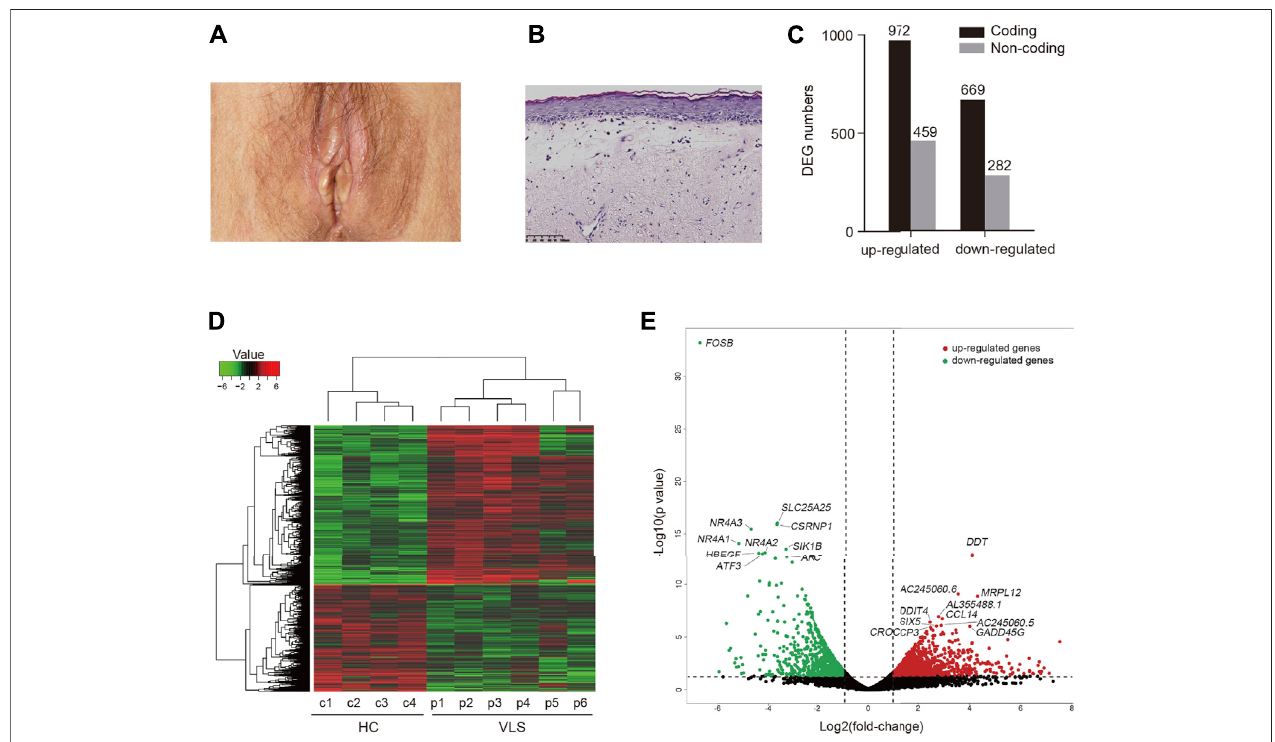
FIGURE1| Differentialgeneexpressionanalysis. (A) ClinicalmanifestationofapatientwithVLS. (B) HistologyofVLSspecimenstainedwithhematoxylinandeosin. Scalebar,100 μ m. (C) BarchartofthenumbersofDEGs. (D) HeatmapvisualizationofDEGsidenti fi edinVLS vs .HealthyControls(HC). (E) VolcanoplotshowingDEGs. Top ten upregulated (red) and downregulated genes (green) sorted by statistical signi fi cance ( p -value) were labeled.